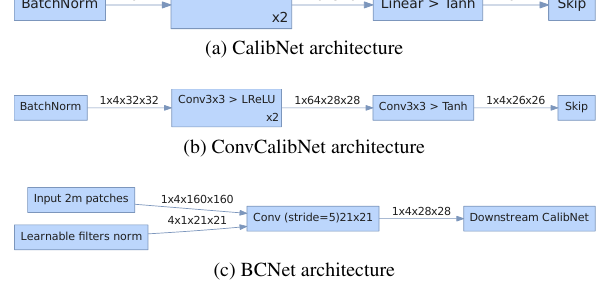
Figure 2. Architectures of the proposed networks. Skip block is a residual connection that adds the input of the network. LReLU is a Leaky ReLU activation function. Learnable filters in BCNet are normalized so that each of them sums up to